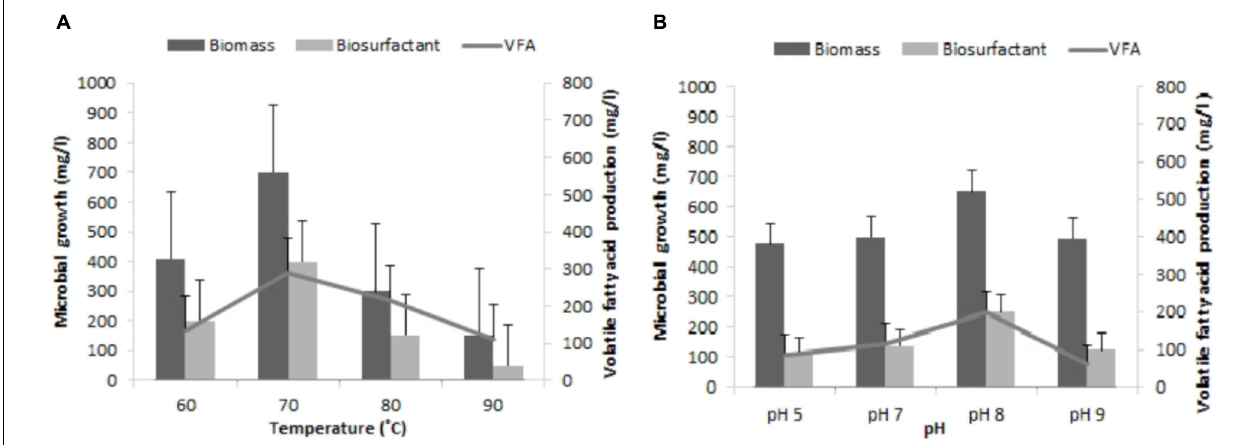
FIGURE 6 | Influence of reservoir conditions on growth of the microbial cell, bio-surfactant and VFA by TERIJ-188 in Baltech medium prepared anaerobically using nitrogen gas. Data was recorded after 10 days of incubation. (A) At different temperatures (60, 70, 80, and 90 ◦ C). (B) At range of pH values (5.0, 7.0, and 9.0).